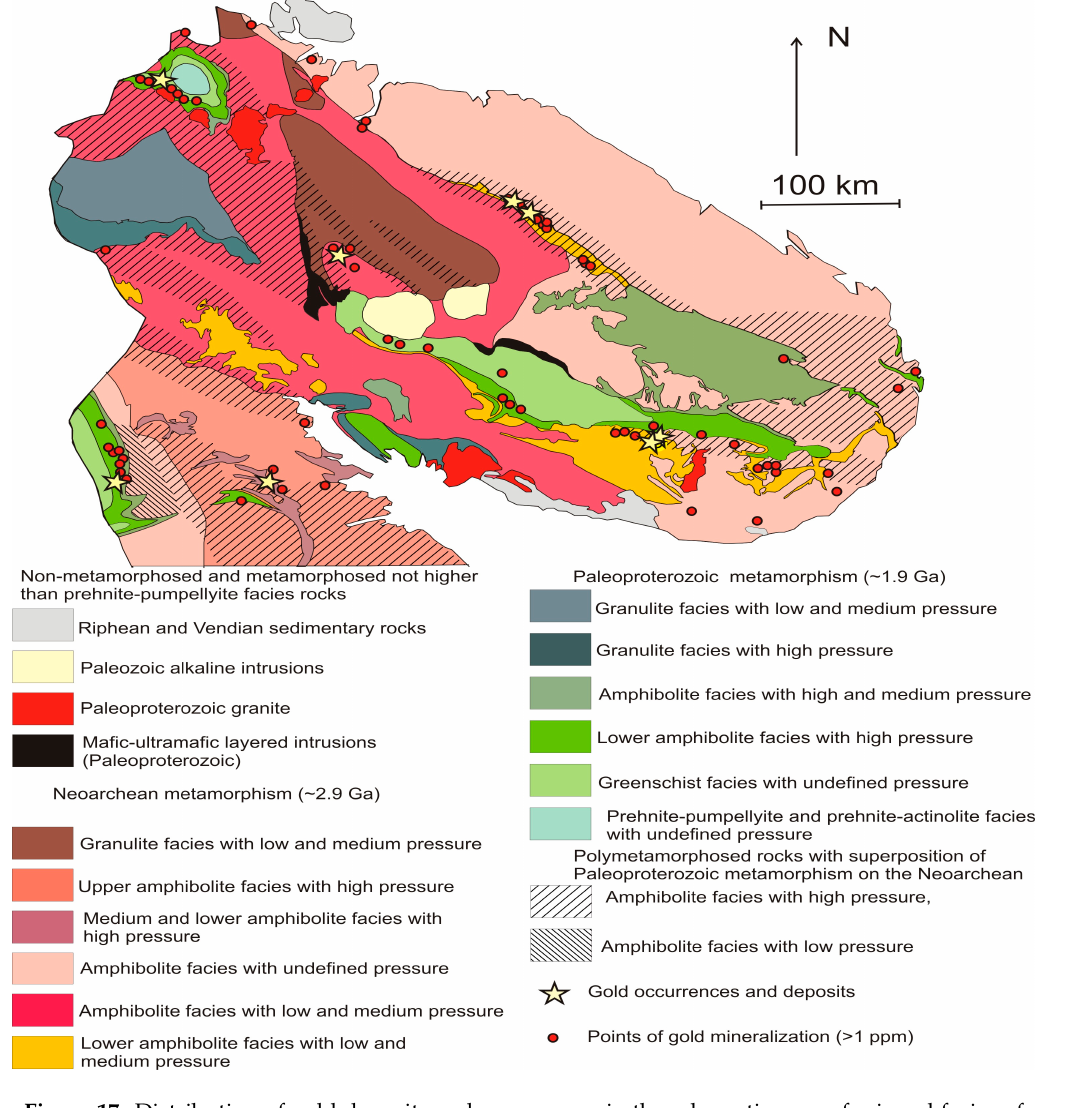
Figure 17. Distribution of gold deposits and occurrences in the schematic map of mineral facies of metamorphic rocks in the northeastern part of the Fennoscandian Shield (Modified from Reference [47]).